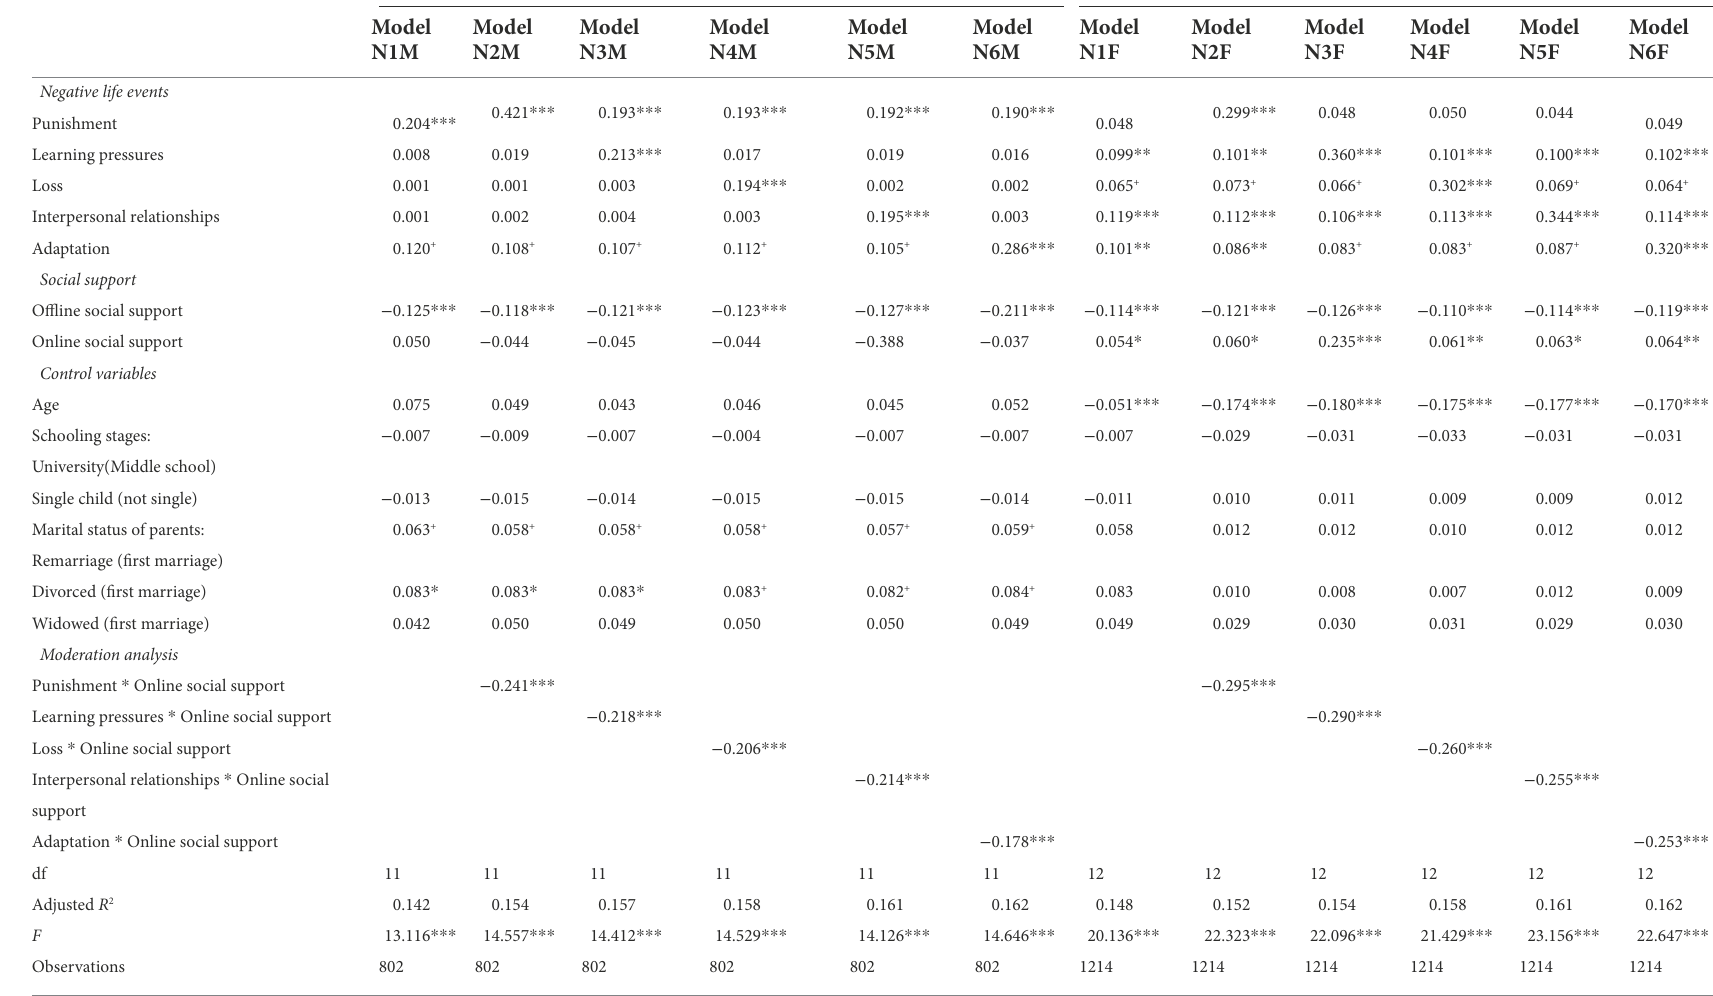
TABLE 4 The direct and moderating effects of online social support on suicidal ideation among male and female youth. Independent